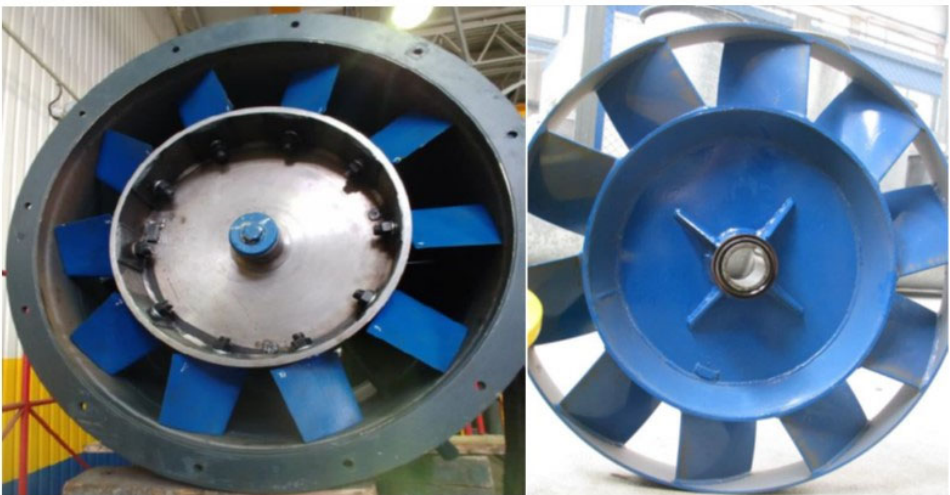
Figure 14. View of the rotor with blades sockets.